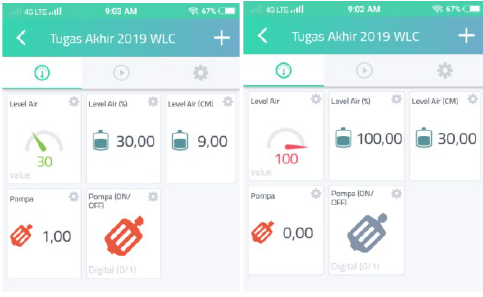
Figure 16. Android display for relay